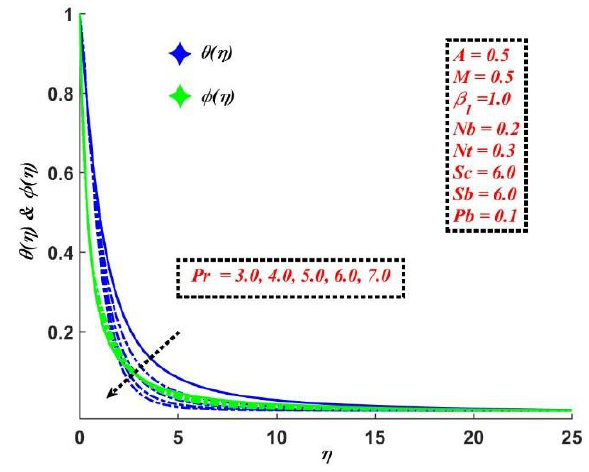
Figure 8. Influence of the Prandtl number on 𝜃(𝜂) and 𝜙(𝜂) .